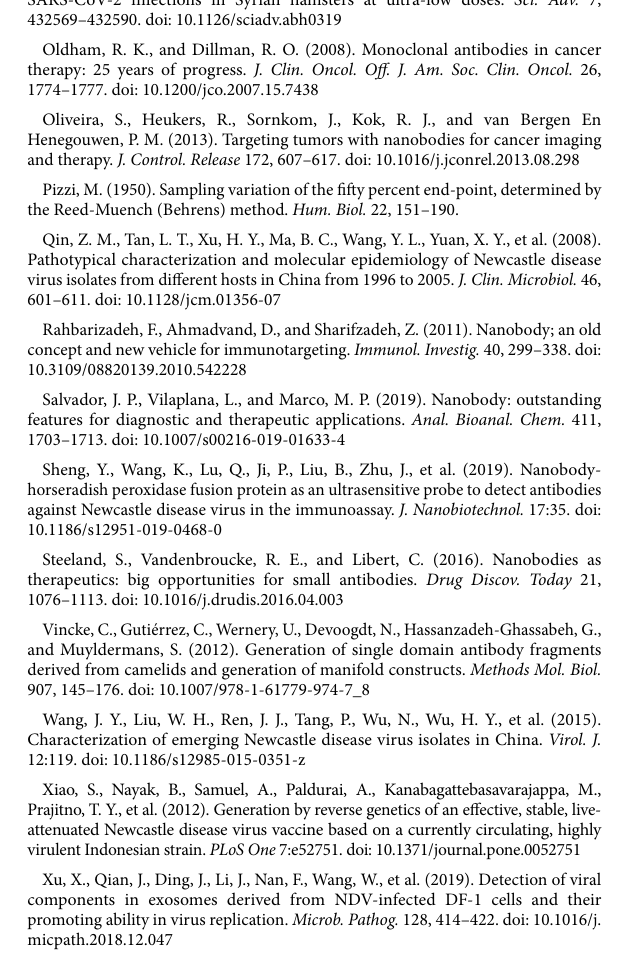
SUPPLEMENTARY FIGURE S2 Detection of the different Class II NDV strains after infection of the different cell lines by IFA. NDV LaSota strain infected different cell lines (Upper left). NDV F48E9 strain infected different cell lines (Upper right). NDV JS/17 strain infected different cell lines (Lower left). NDV sx10 strain infected with different cell lines (Lower